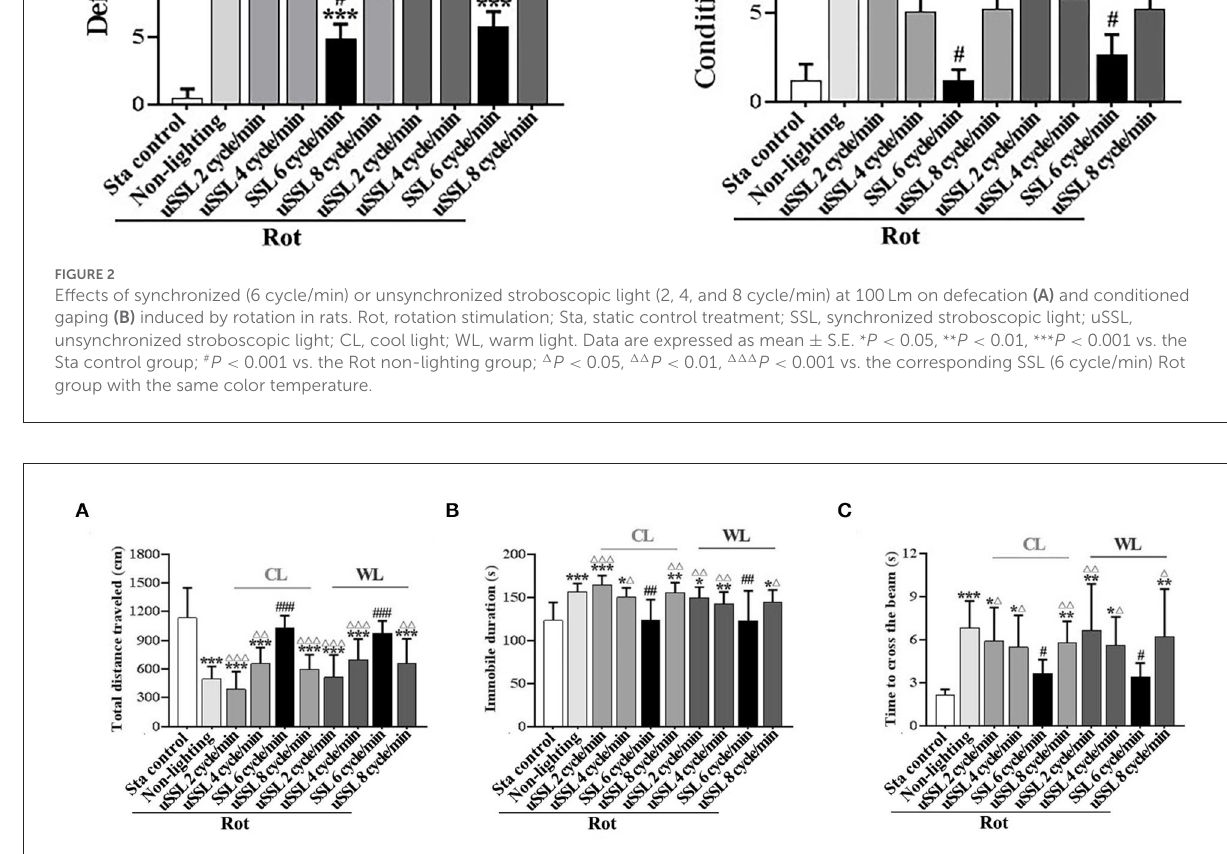
FIGURE3 Effects of synchronized (6 cycle/min) or unsynchronized stroboscopic light (2, 4, and 8 cycle/min) at 100Lm on hypoactivity and balance disturbance induced by rotation in rats. Spontaneous locomotion activity was characterized by total distance traveled (A) and immobile duration (B) . Motor coordination was assessed by measuring the time to traverse the balance beam (C) . Rot, rotation stimulation; Sta, static control treatment; SSL, synchronized stroboscopic light; uSSL, unsynchronized stroboscopic light; CL, cool light; WL, warm light. Data are expressed as mean ± S.E. * P < 0.01, ** P < 0.01, *** P < 0.001 vs. the Sta control group; # P < 0.05, ## P < 0.01, ### P < 0.001 vs. the Rot non-lighting group. 1 P < 0.05, 11 P < 0.01, 111 P < 0.001 vs. the corresponding SSL (6 cycle/min) Rot group with the same color